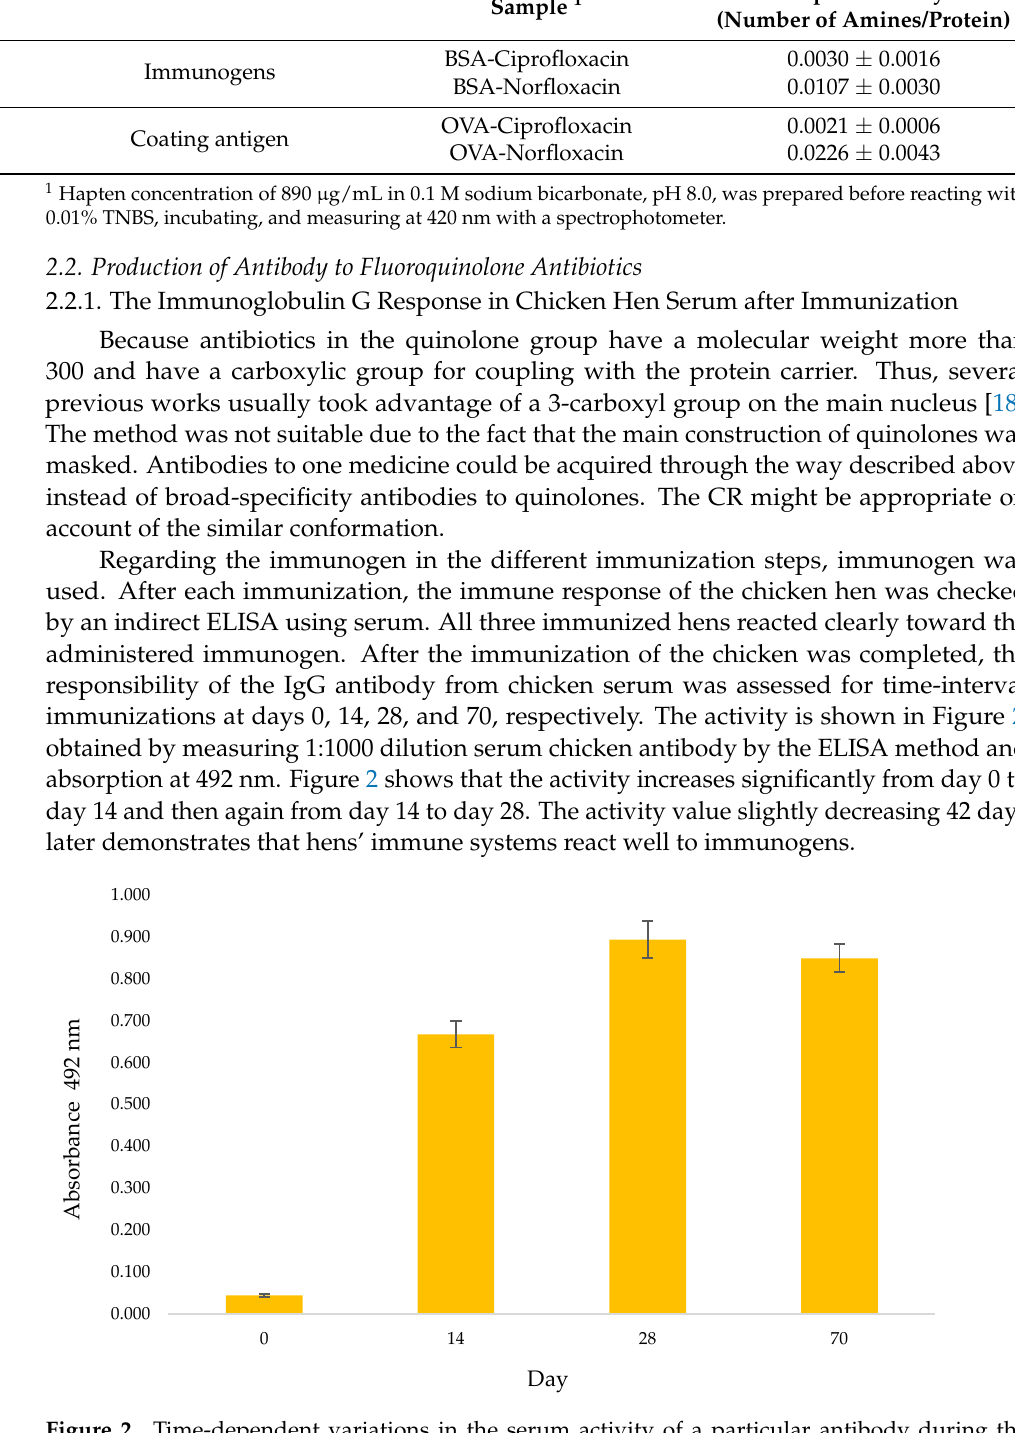
Figure 2. Time-dependent variations in the serum activity of a particular antibody during the experiment. Chickens’ antibody activities in 1:1000 dilution was measured by ELISA and shown as absorbance 492 nm, and error bars indicate the standard deviation (n = 2).